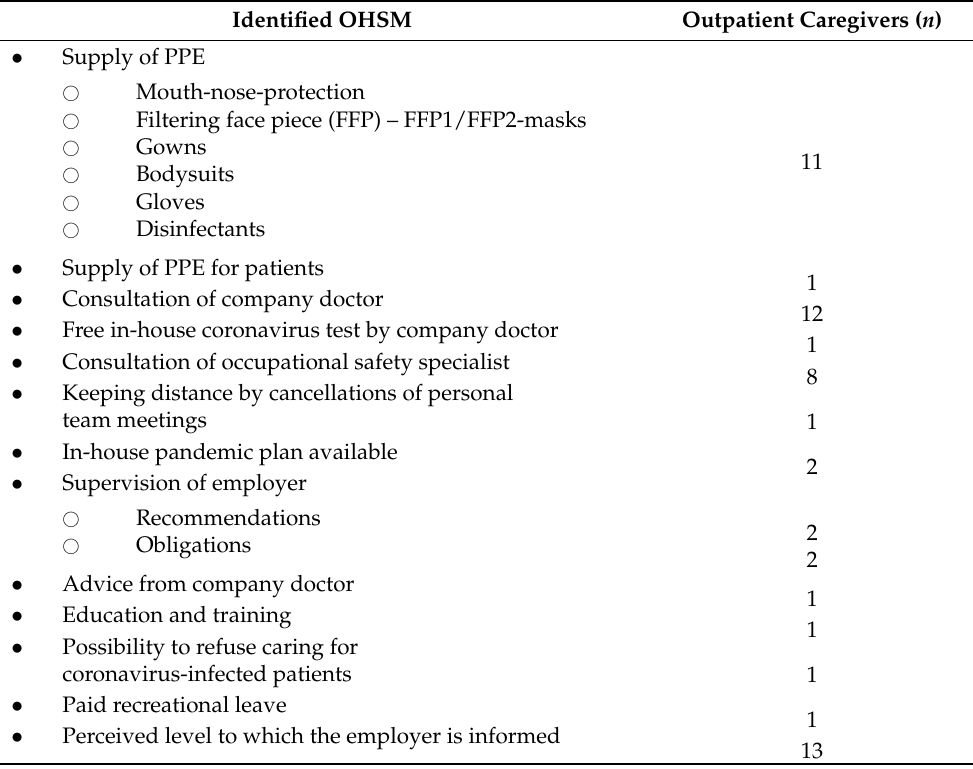
Table 3. Identified OHSM mentioned by interviewed outpatient